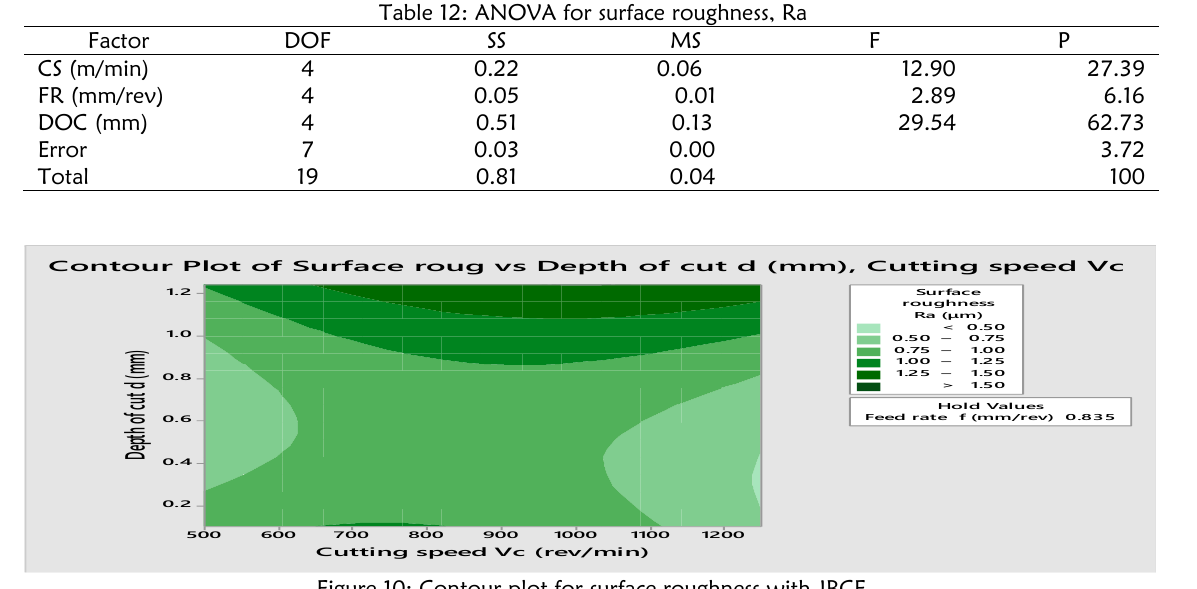
Figure 10: Contour plot for surface roughness with JBCF